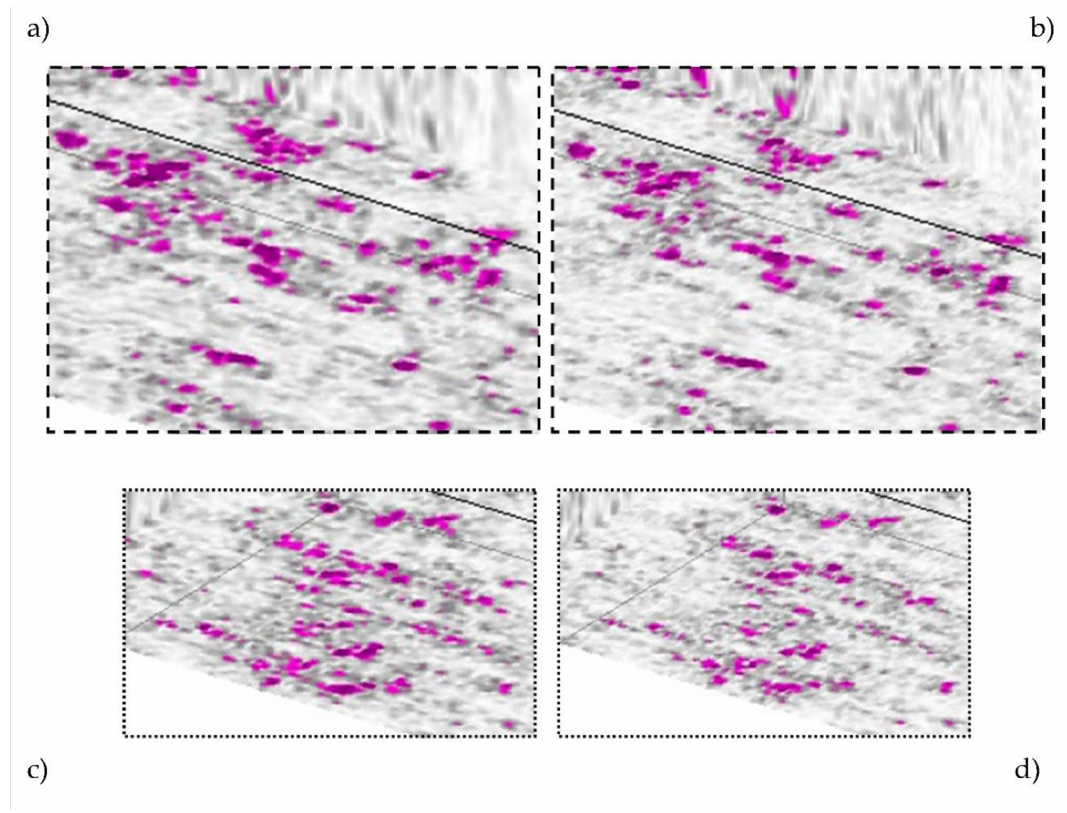
Figure 8. Details of the horizontal slices depicted in Figure 7. Details of Figure 7a ( a ) and Figure 7b ( b ) (extend indicated by the dashed black lines). Detail of Figure 7a ( c ) and Figure 7b ( d ) (extend indicated by black dotted lines). Color scale is the same as in Figure